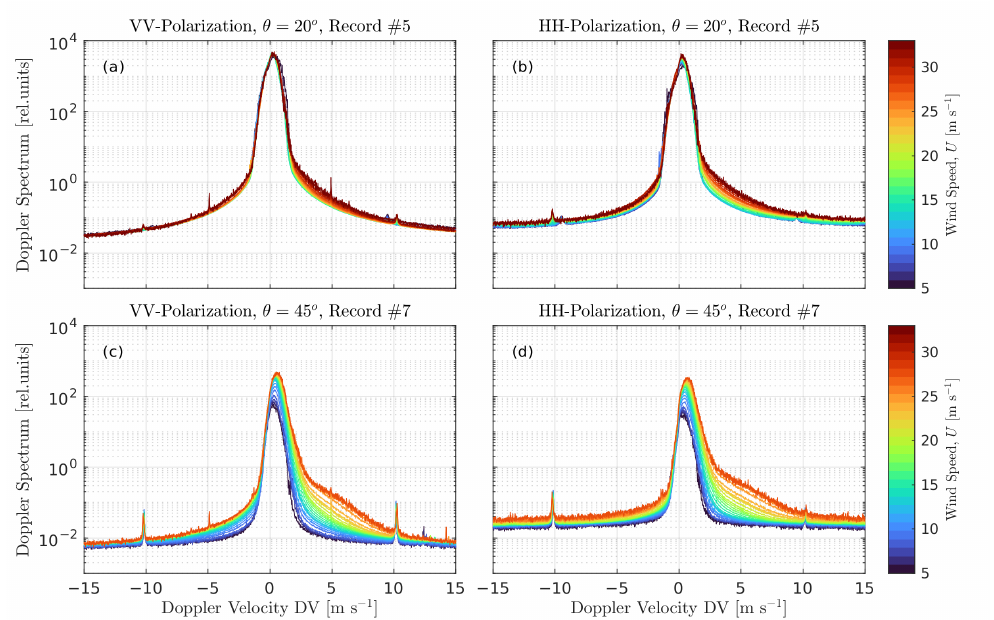
Figure 4. Doppler spectra averaged at different wind speeds (color-coded) for ( a , b ) θ = 20 ◦ and ( c , d ) θ = 45 ◦ . ( Left column )—VV-polarization, ( right column )—HH-polarization. The mean NRCS wind dependencies (Figure 5) do not explicitly exhibit any spe- cific features, suggesting a backscattering regime change at strong winds. Mean NRCS dependencies are qualitatively similar to the background Ku-band geophysical model func- tions (GMF) derived from the Tropical Rainfall Measurement Mission (TRMM, the closest θ = 18 ◦ is used, see the bottom curve in their Figure 7 [30]) and NSCAT4 [43,44] satellite data. The TRMM GMF possibly suggests a noticeable NRCS decrease for U > 35 m s − 1 , i.e., wind speeds exceeding our observation range. In general, this behavior is in line with the often-reported co-polarized backscatter saturation, possibly due to a wind stress attenuation at strong winds [45–49].